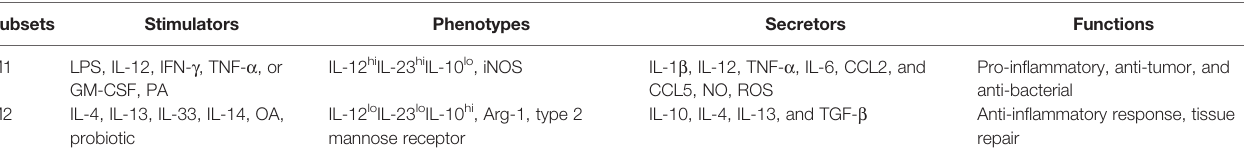
TABLE 2 | Comparison of M1- and M2-like macrophages.